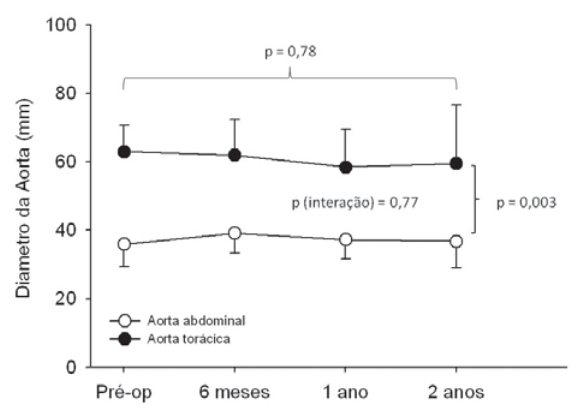
Fig. 3 - Variação média dos diâmetros da aorta torácica e abdominal no decorrer do tempo, onde se observa a ausência de variação dos diâmetros após o tratamento endovascular